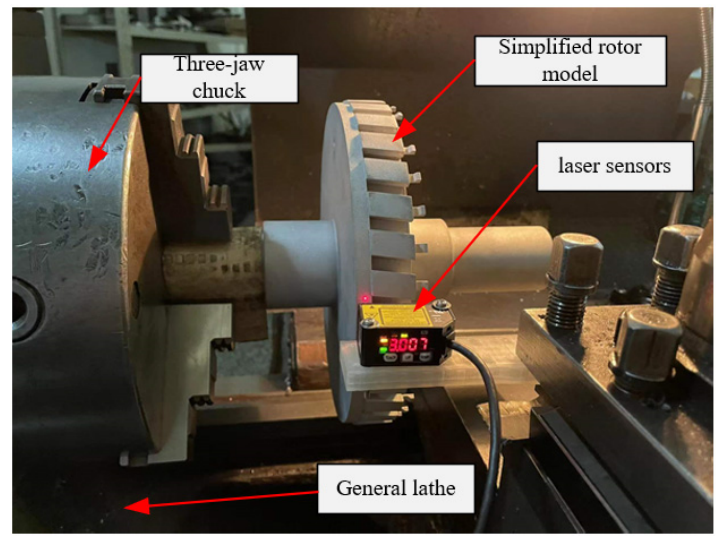
Figure 6. Experimental setup diagram.